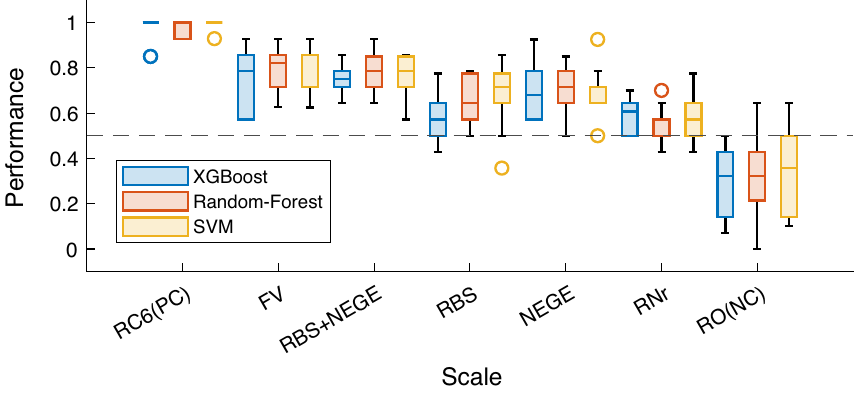
Figure 2. Results for the accuracy metric in tenfold cross-validation. [RC6 (PC): Restructured Clinical 6 (Positive Control); F&V: Fenigstein & Vanable; RNr: RBS + NEGE (Reduced); RO (NC): Random Observations (Negative Control); dashed line : randomness threshold].